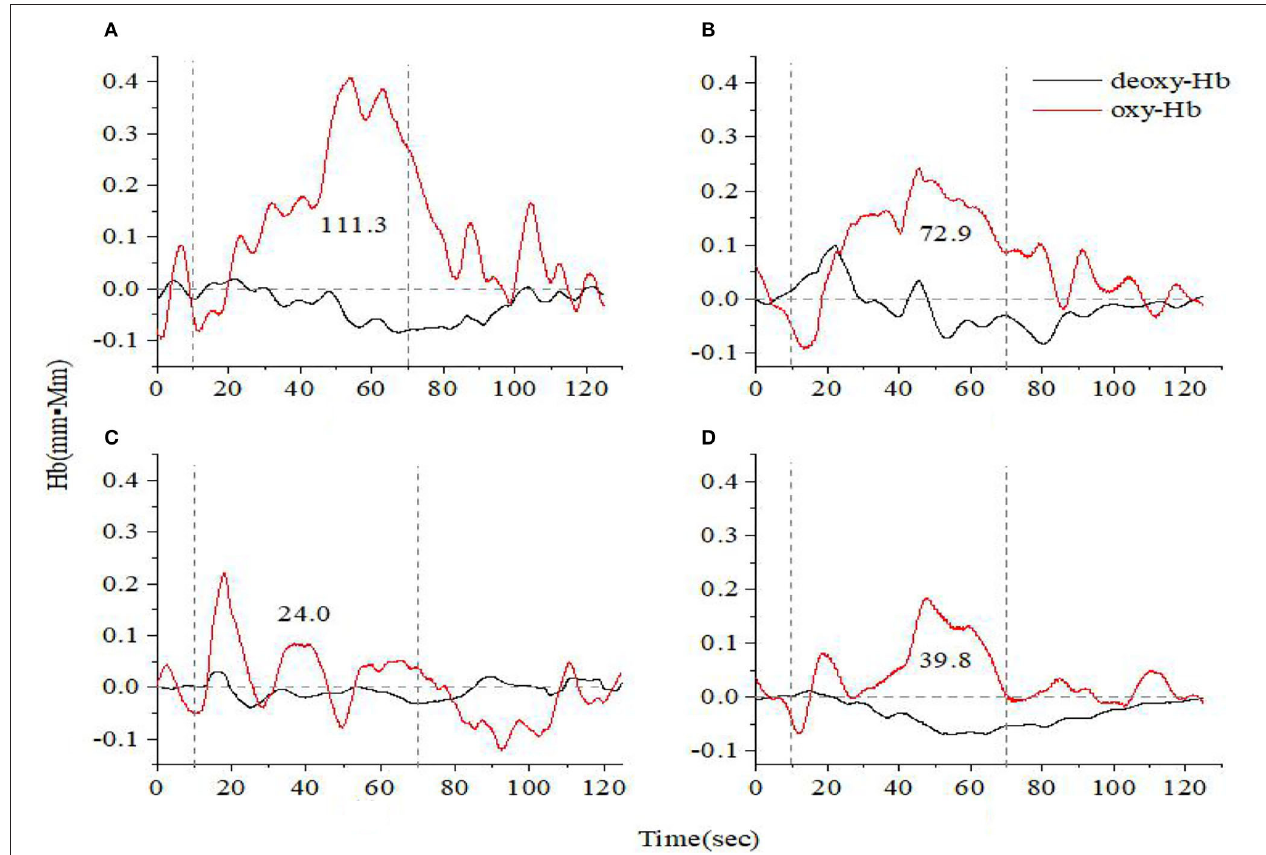
FIGURE 1 | Time course of hemoglobin concentration changes in a representative healthy control (A) and a representative anxiety and depression patient at the acute (B) , consolidation (C) , and maintenance stages (D) . All of them completed the verbal fluency task. The red line indicates the amount of change in oxyhemoglobin concentration (oxy-Hb), and the black line indicates the amount of change in deoxyhemoglobin concentration (deoxy-Hb). The numbers indicate integral values.